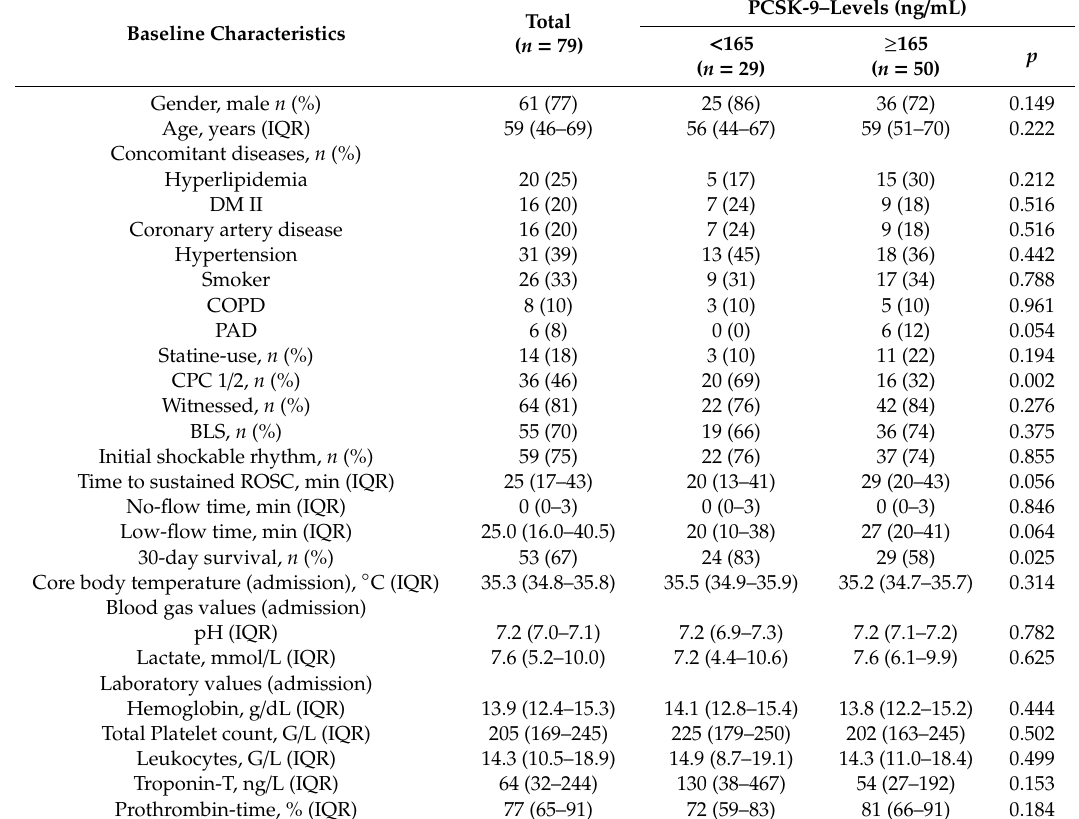
Table 1. Baseline Characteristics: Categorical data are presented as counts and percentages, continuous data as medians and interquartile ranges